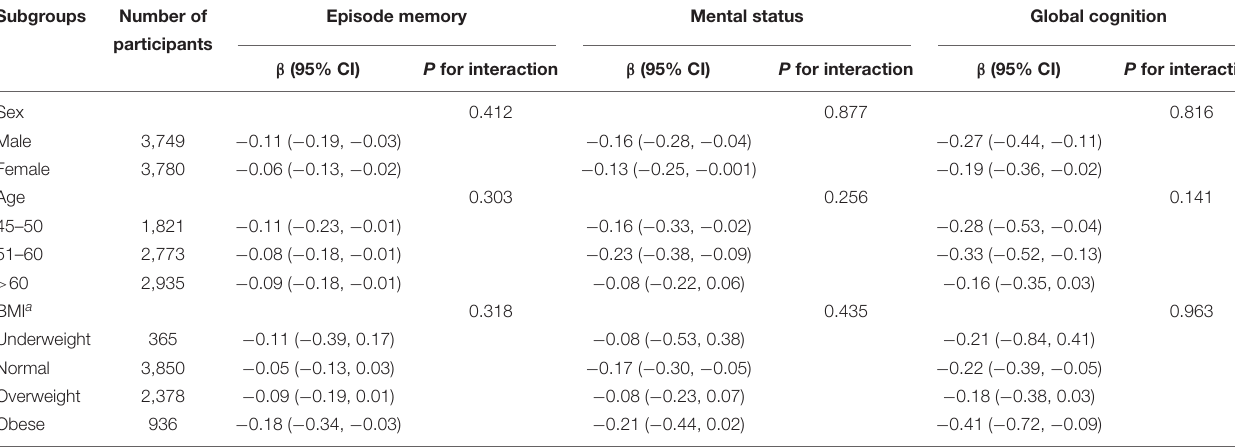
TABLE 3 | Associations between baseline arthritis and subsequent cognitive functions in subgroups. Subgroups